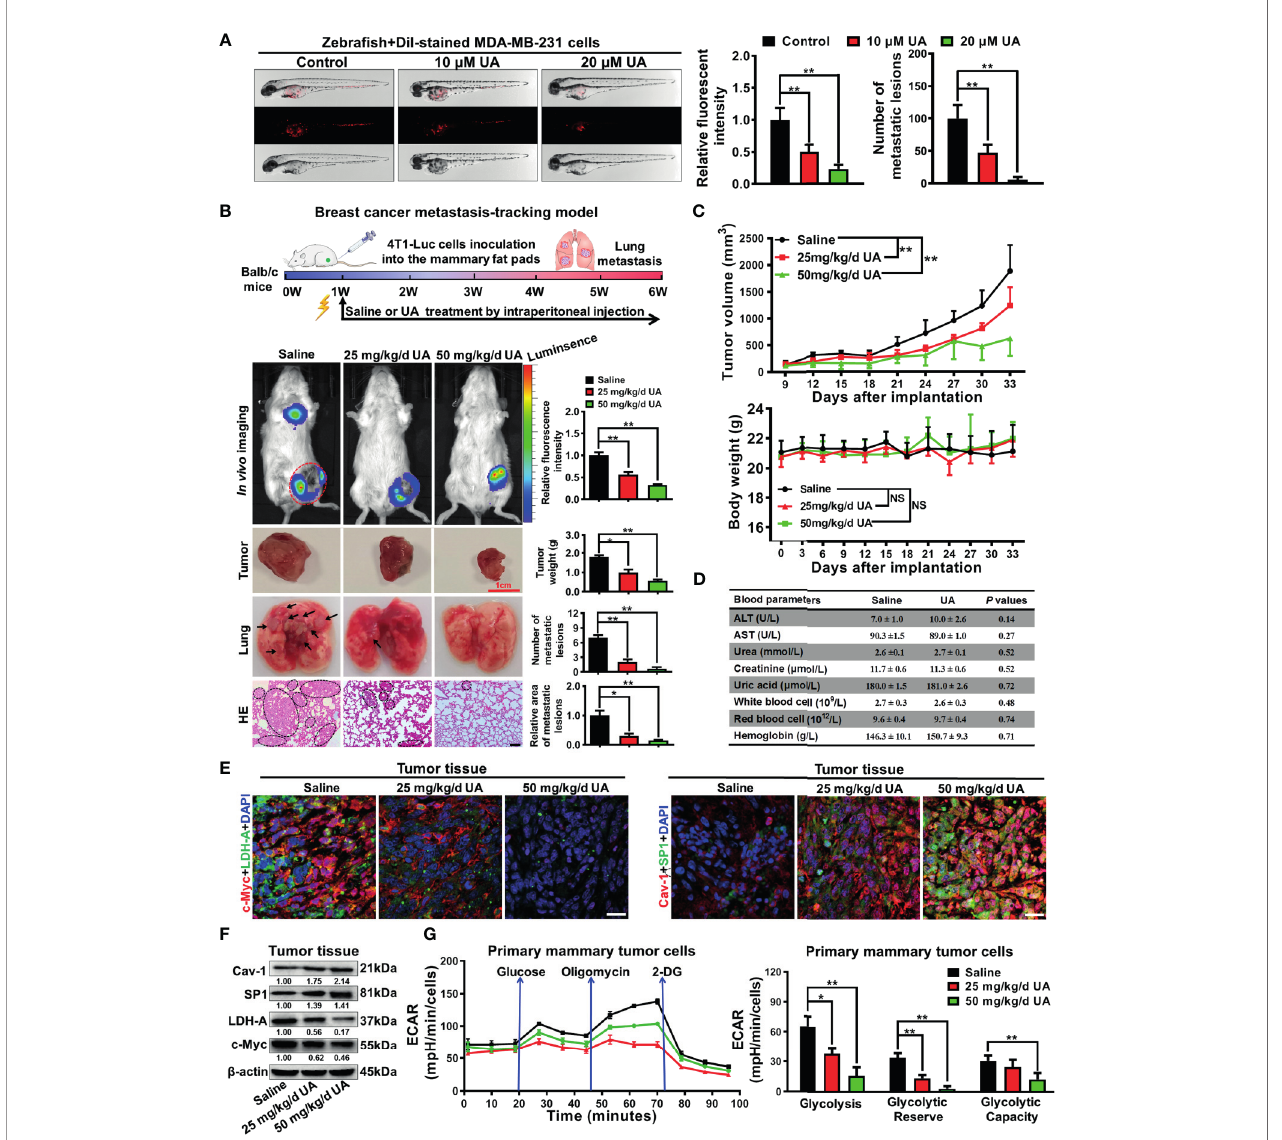
FIGURE 6 | Ursolic acid inhibits breast cancer growth and metastasis in zebra fi sh and mouse xenotransplantation models of breast cancer without observable toxicities. (A) The juvenile zebra fi sh bearing the Dil-stained breast cancer MDA-MB-231 cells were treated with 10~20 m M ursolic acid for 48 h The proliferation and dissemination of the injected MDA-MB-231 cells in the zebra fi sh breast cancer xenotransplantation model were observed under a stereomicroscope. N = 3. (B, C) The 4T1-Luc breast cancer xenograft model was established by subcutaneously injecting 4T1-Luc cells into the mammary fat pads of mice. Ursolic acid administration (25~50 mg/kg/d) by intraperitoneal injection suppressed the growth and lung metastasis of 4T1-Luc xenografts in mouse breast cancer xenotransplantation models. N = 6. Scale bar = 100 m m. (D) The hepatotoxicity, nephrotoxicity and hematotoxicity of ursolic acid in mice were detected by biochemical analysis. N = 3. (E, F) Tissue immuno fl uorescence assay (E) and Western blotting assay (F) were conducted to investigate the effect of ursolic acid on the expression levels of LDH-A, c-Myc, SP1 and Cav-1 in mammary tumor tissues. N = 3. Scale bar = 20 m m. (G) The effect of ursolic acid on glycolytic metabolism of primary breast cancer cells was investigated by measuring ECARs. N = 3. * p < 0.05. ** p <